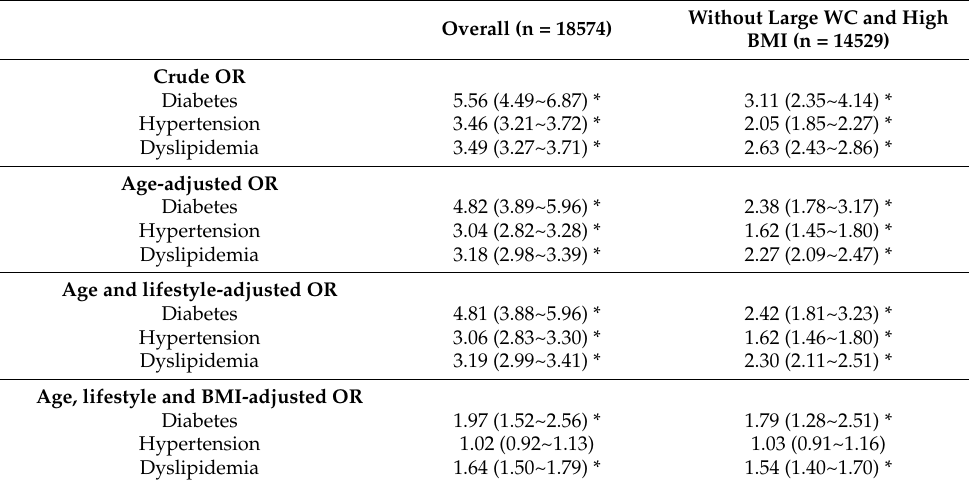
Table 2. Odds ratios for diabetes, hypertension and dyslipidemia of subjects with high waist-to-height ratio vs. subjects without high waist-to-height ratio in the overall subjects and subjects not showing large waist circumference and high